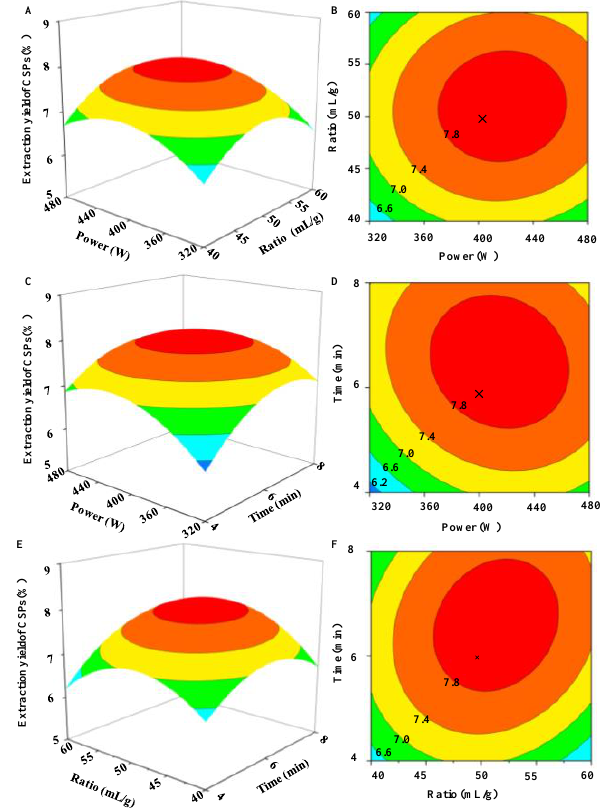
Figure 2. Three-dimensional response surface (left) and two-dimensional contour (right) plots of microwave-assisted extraction. ( A , B ) microwave power and ratio of water to raw material; ( C , D ) microwave power and microwave extraction time; ( E , F ) ratio of water to raw material and microwave extraction time, respectively.